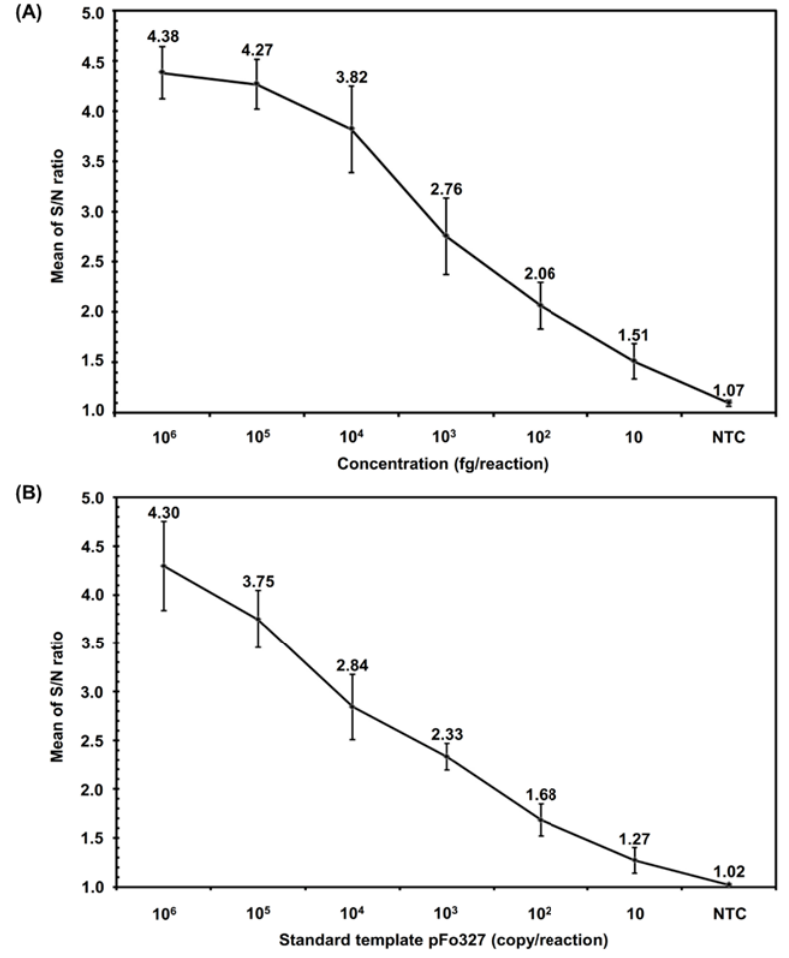
Figure 2. Sensitivity evaluation of the insulated isothermal PCR assay of Fusarium oxysporum (Fo iiPCR). Serial dilutions of ( A ) F. oxysporum genomic DNA and ( B ) standard DNA were subjected to